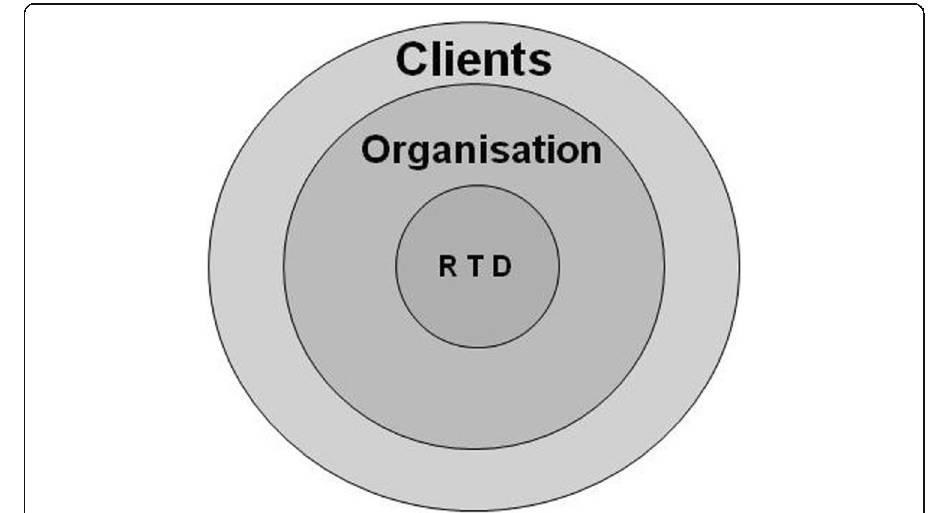
Fig. 23 A circular 2D model of society or